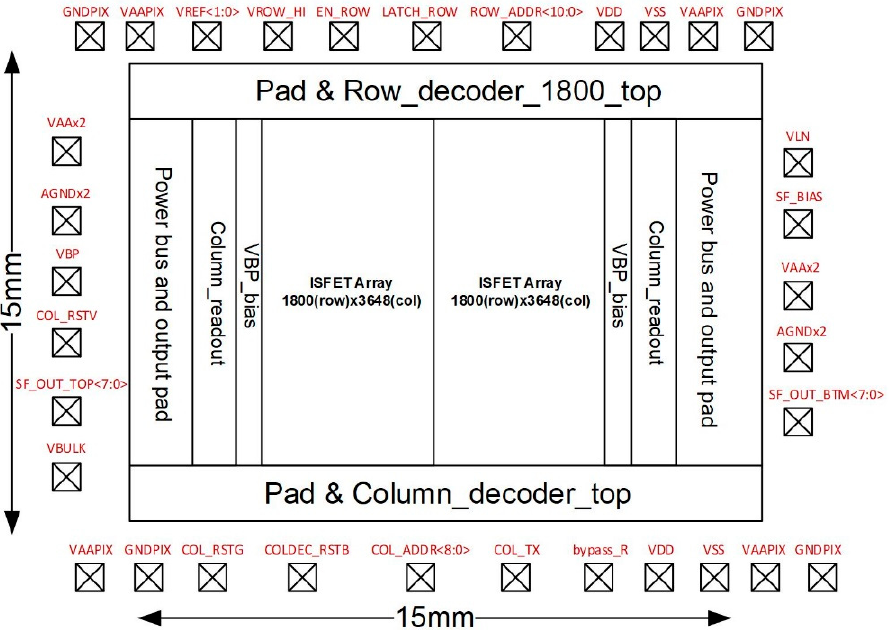
Figure 2. The structure block diagram of the ISFET sensor array chip. The chip can be divided into sensor array unit and read circuit, where the sensor array includes 3600 × 3648 pixel units, and the reading circuit includes row decoder module, column decoder module, VBP bias module, and column readout module.